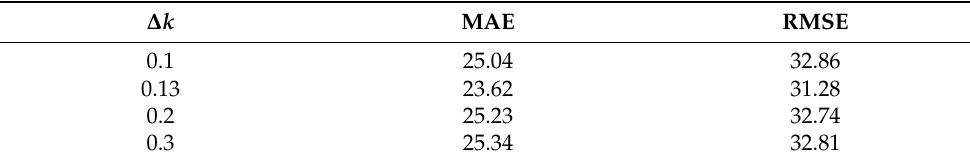
Table 2. Average statistics of quantum walk simulation with different ∆ k